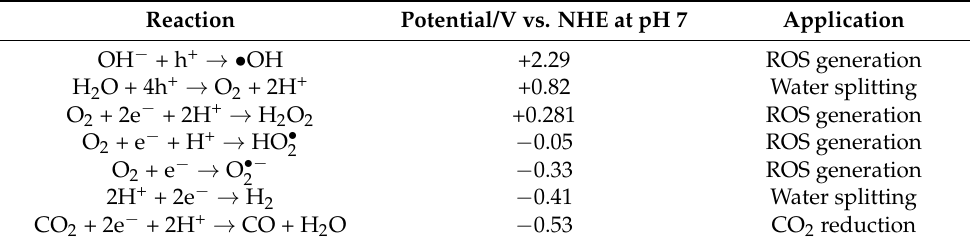
Table 1. Reduction and oxidation reactions and potentials from